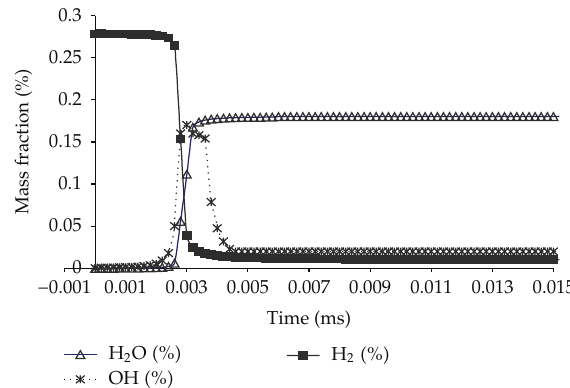
Figure 9: Mass fraction profile of the H 2 , OH − and products H 2 O.